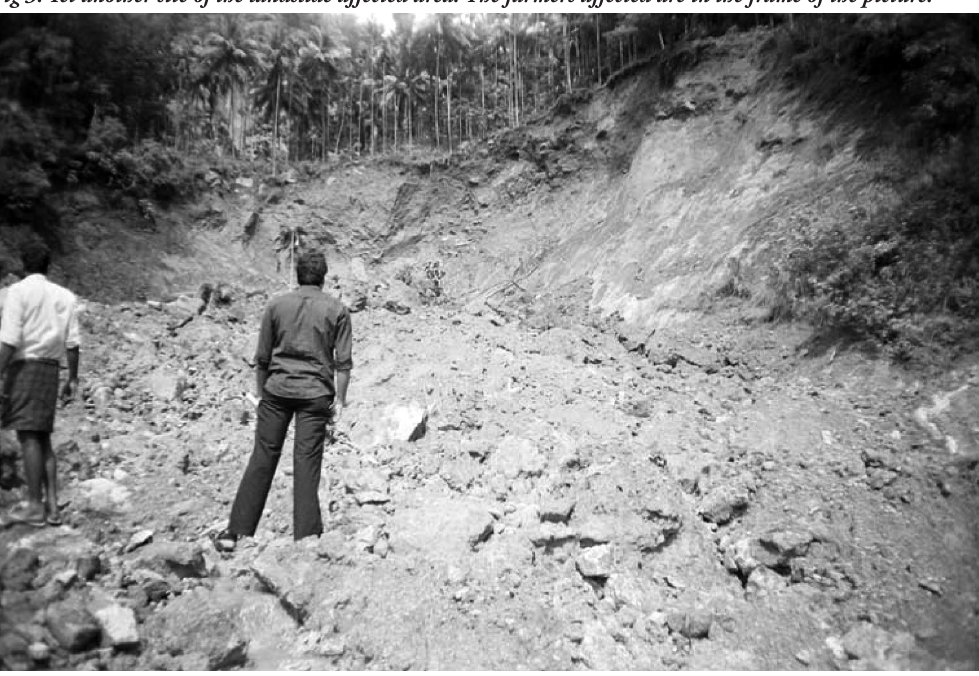
SanthaSource: Photos taken during the fieldwork by Sunil D Fig 4: Infrastructure like roads and drinking water supply were severely affected by the landslides